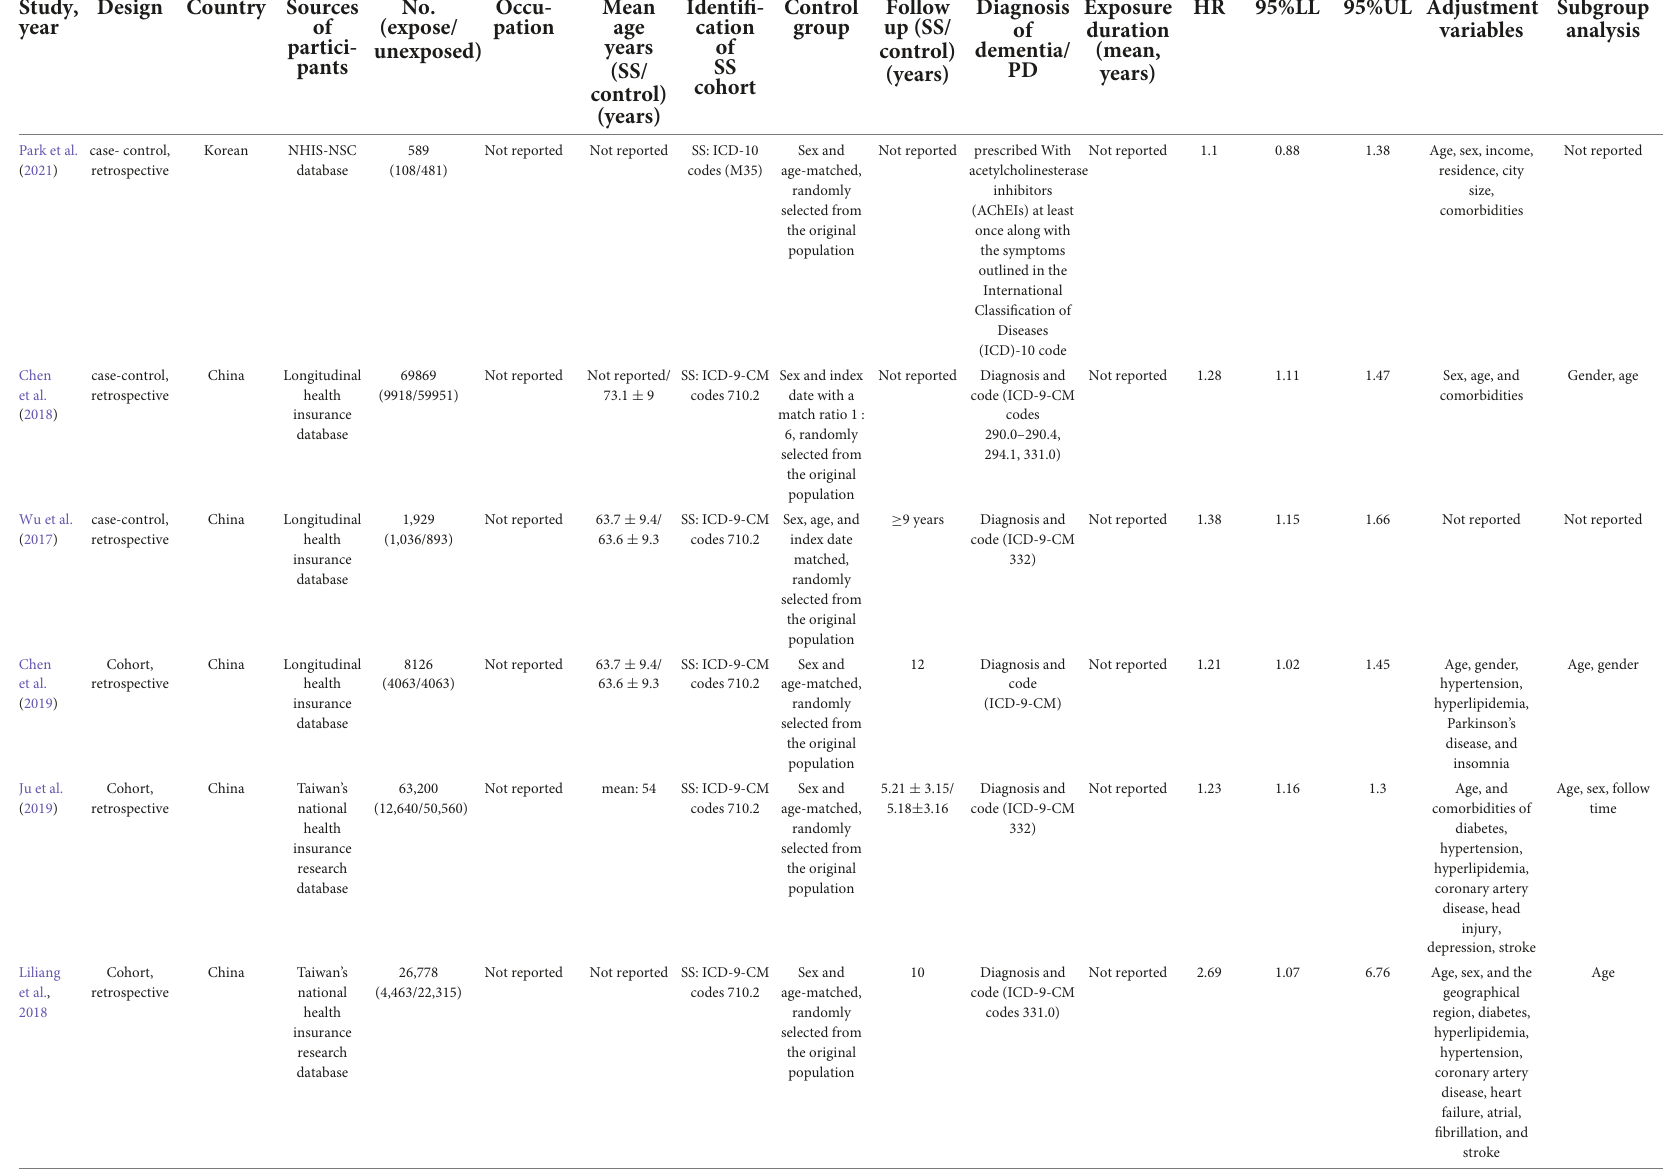
TABLE 1 The characteristics of included studies. Study, Design Country Sources year